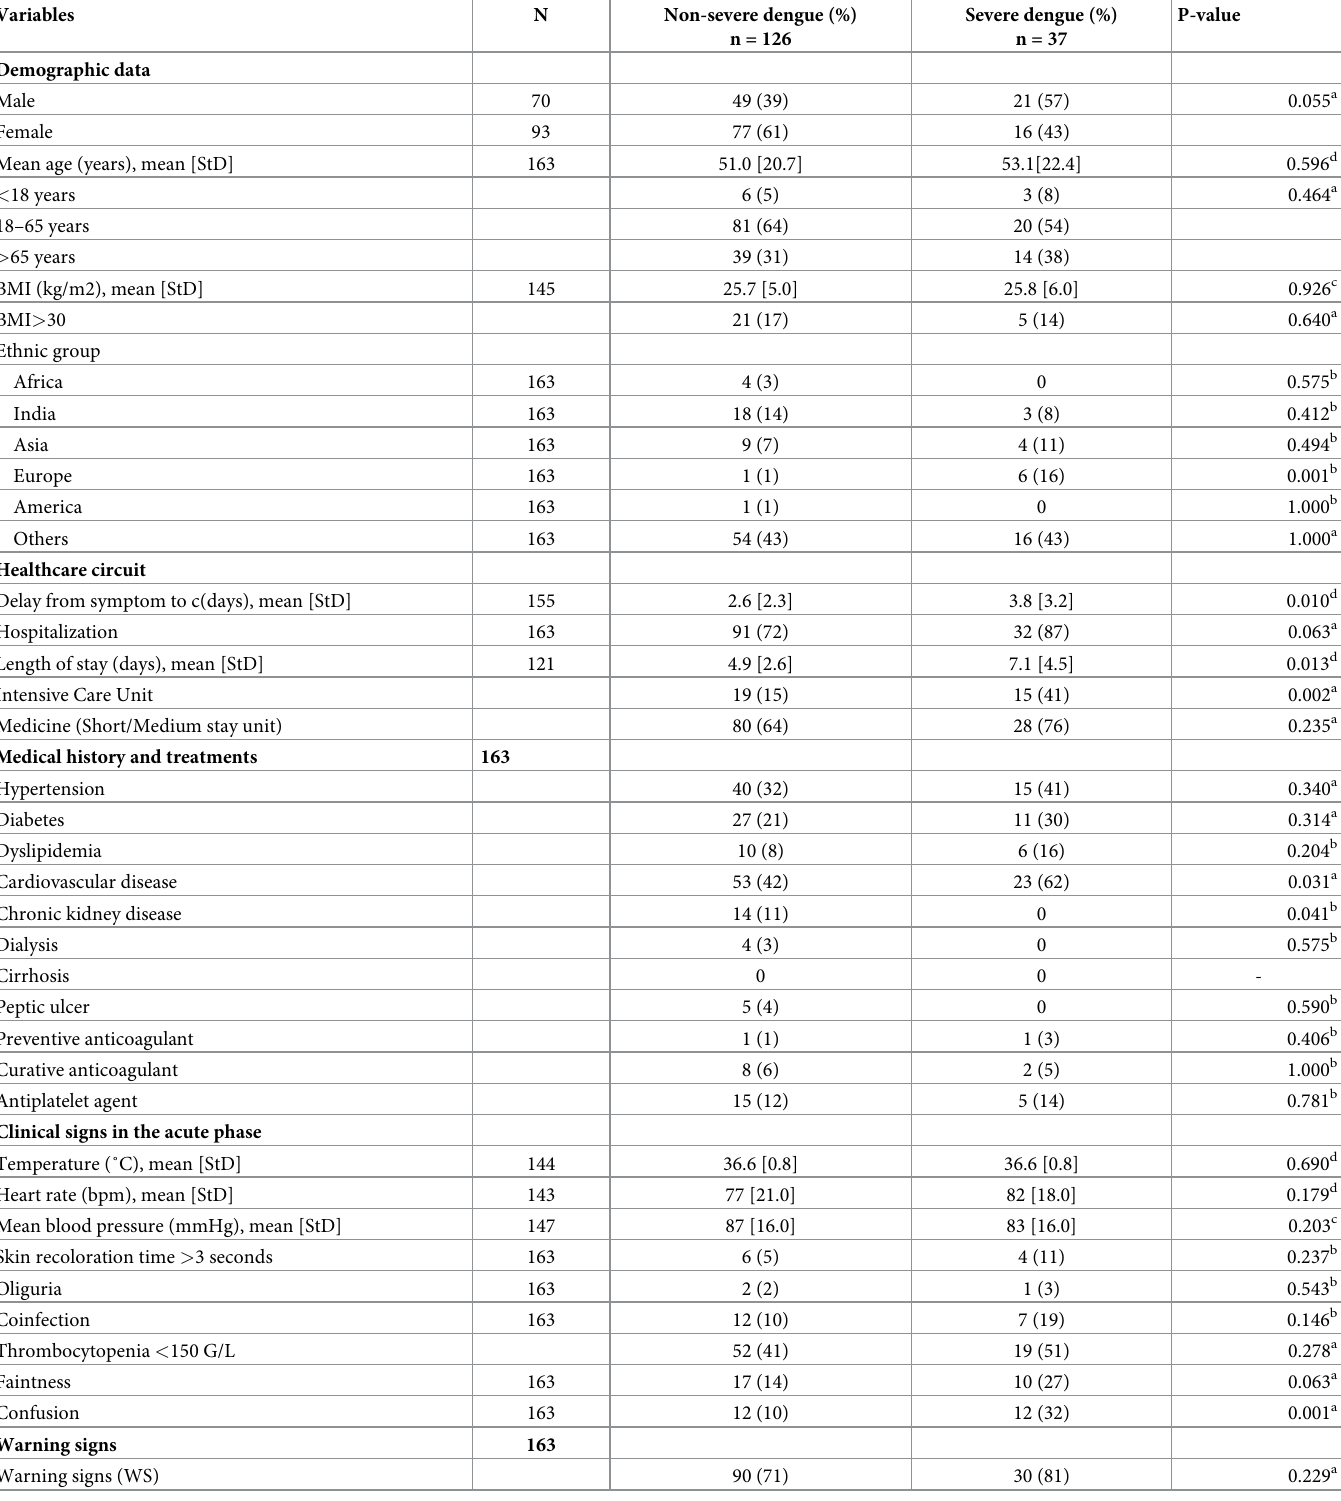
Table 1. Demographic, clinical and biological data in severe dengue and non-severe dengue, in DENV positive patients. Reunion Island 2019 (N = 163).